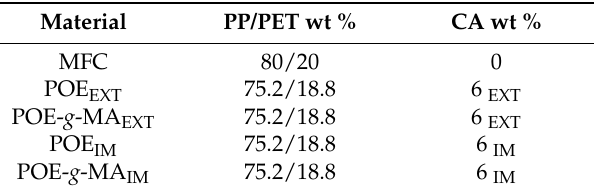
Table 1. Formulations of the